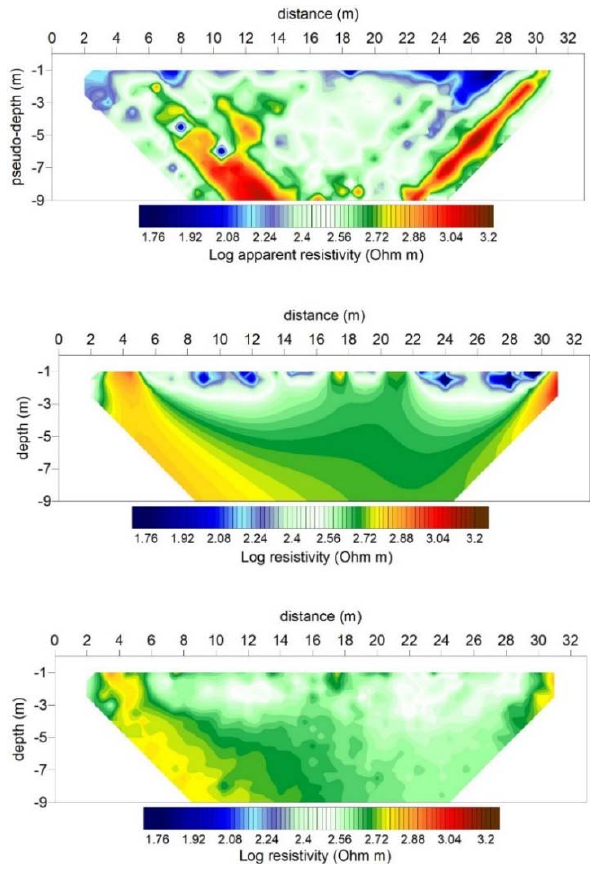
Figure 13. Fading procedure of a systematic noise effect from a field dataset: the DD field pseudosection (upper section), the classical PERTI section (intermediate section), the filtered best ‐ fit E ‐ PERTI section (lower section).